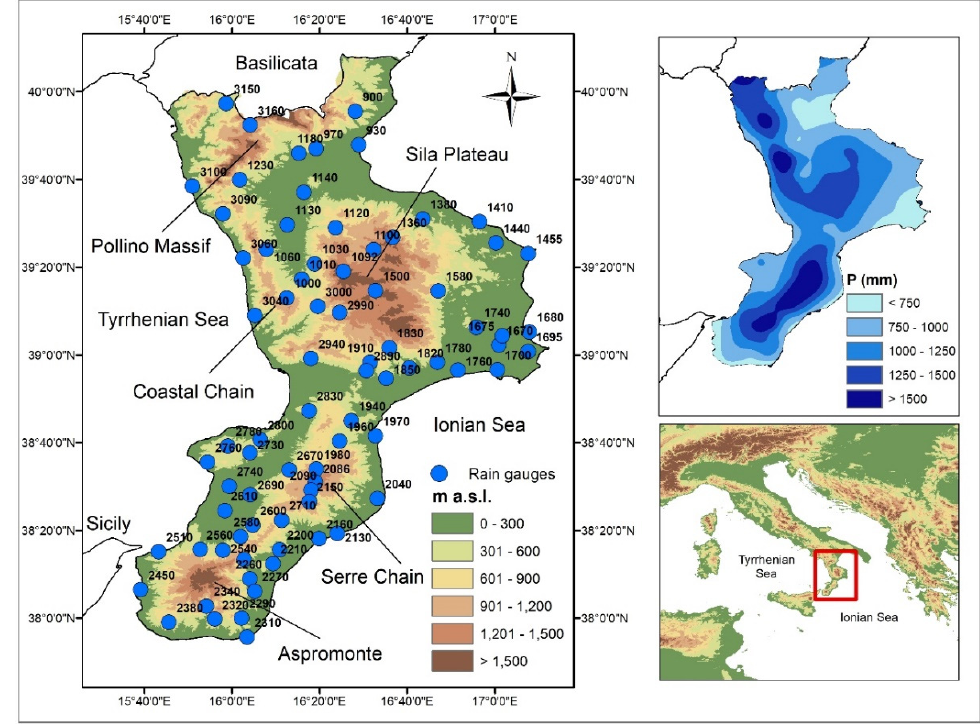
Figure 1. Localization of the rain gauges on a digital elevation model of the Calabria region and the spatial distribution of the mean annual rainfall. spatial distribution of the mean annual